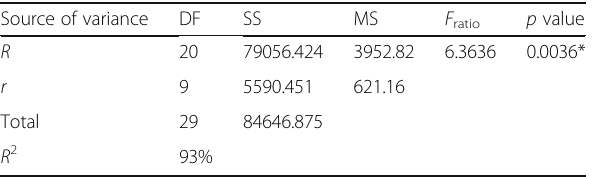
Table 3 Analysis of variance for the fitted model Source of variance